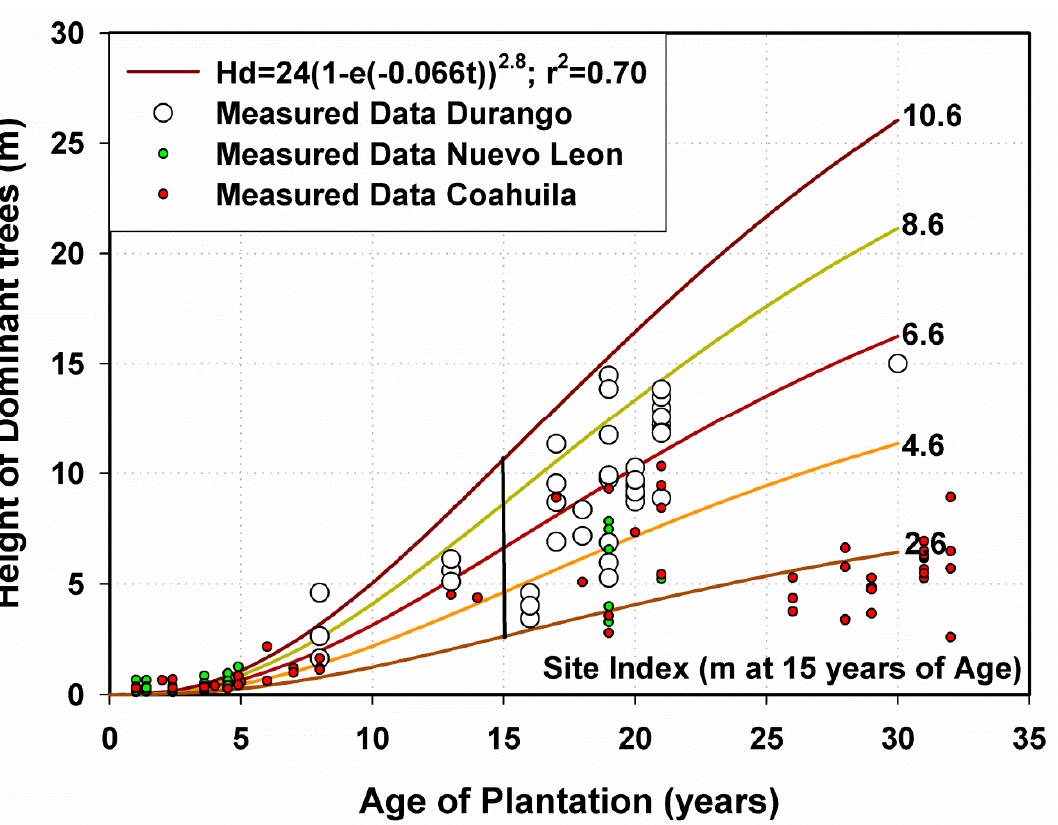
Figure 3. Evaluation of site index using the Chapman-Richards equation for northern Mexico’s non-industrial planted forests with site index values inside for each curve. Lines represent the site index curves.